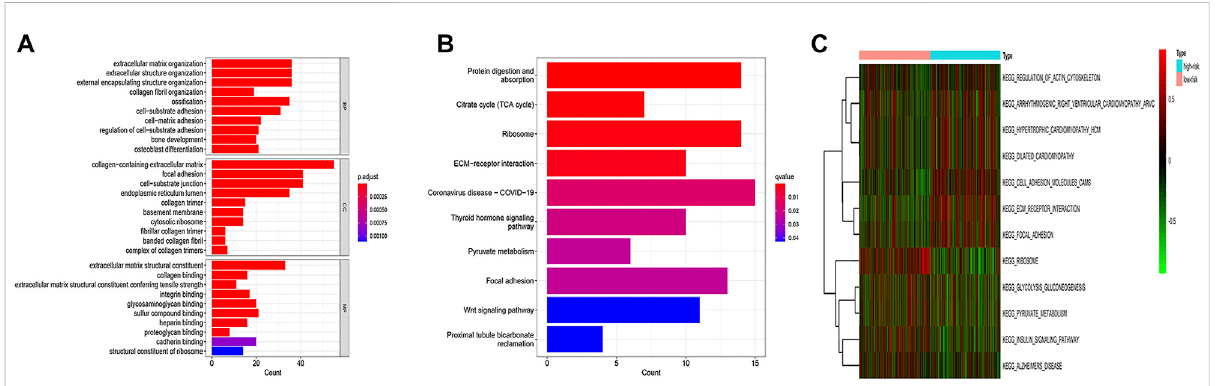
FIGURE 6 GO enrichment analysis (A) , KEGG enrichment analysis (B) , and GSVA analysis (C) of CDRG. (A) The results of GO enrichment analysis showed that these genes were mainly related to the extracellular matrix organization, extracellular framework components, and protein expression. (B) The results of the KEGG enrichment analysis showed that these genes were mainly related to the TCA cycle, ribosome, and protein metabolism. (C) The results showed that ribosome-related pathways, cell adhesion molecule-related pathways, and glycolysis and gluconeogenesis-related pathways had signi fi cant differences between high and low-risk